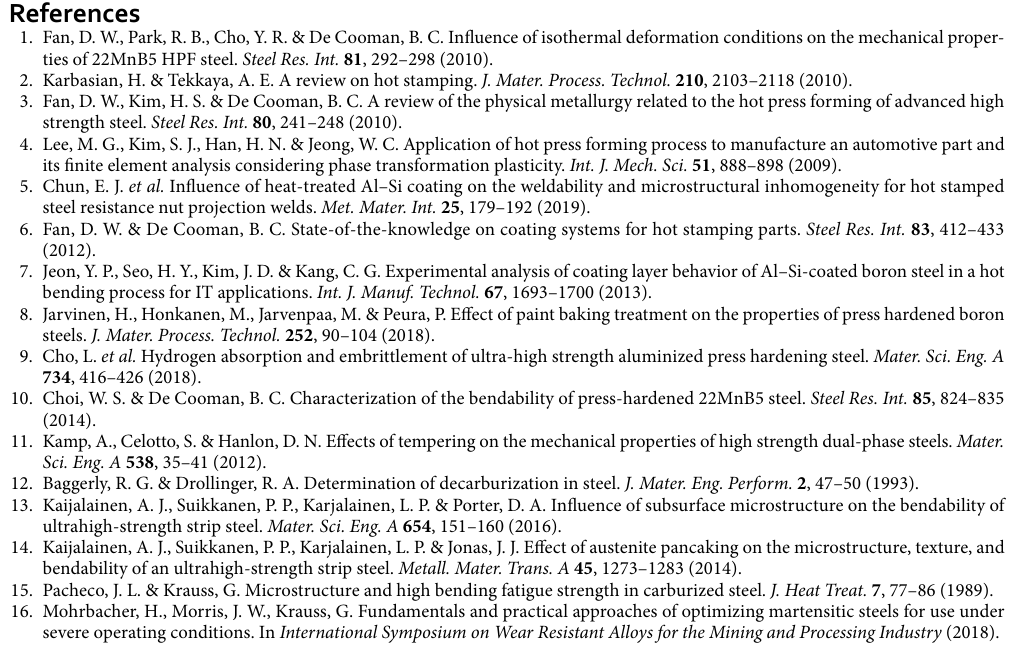
hydraulic testing machine. Figure 11a–c shows the bending test set-up composed of punch, lower rolls, and bending specimen. Interrupted bending tests were also conducted on the same-sized specimens at an interval of a bending angle of 3°. According to the previous bending procedures coupled with a digital image correla- tion (DIC) technique 35–37 , the local tensile strain was concentrated mainly at the center of the outer surface of the bend specimen. Thus, the specimen was bent at a certain bending angle, taken out from the test set-up, and half-sectioned along the longitudinal direction. The reason for sectioning was because the observation of the specimen surface (L–S plane) was not appropriate for examining the bending procedures due to the formation of heavily deformed shear bands on the surface. The central area of the outer surface was polished, etched in a 1%-nital solution, and observed by an SEM. The data that support the findings of this study are available from the corresponding author upon reasonable request.